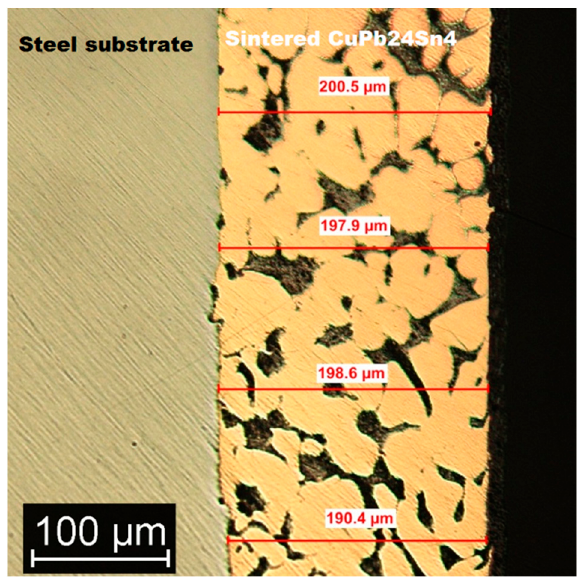
Figure 11. A typical cross-sectional view of the plain-bearing material sintered on a steel back, re- vealing Pb as black inside the microstructure. revealing Pb as black inside the